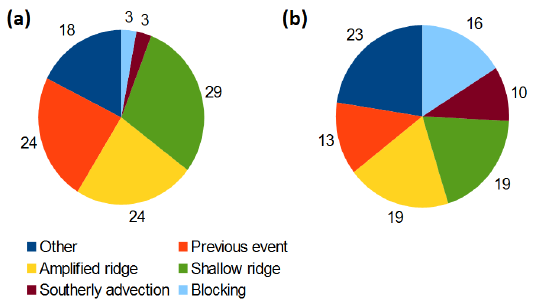
Figure 10. Frequency distribution of the synoptic patterns for days with precipitation events in % for (a) the measured precipitation events and (b) the precipitation events from